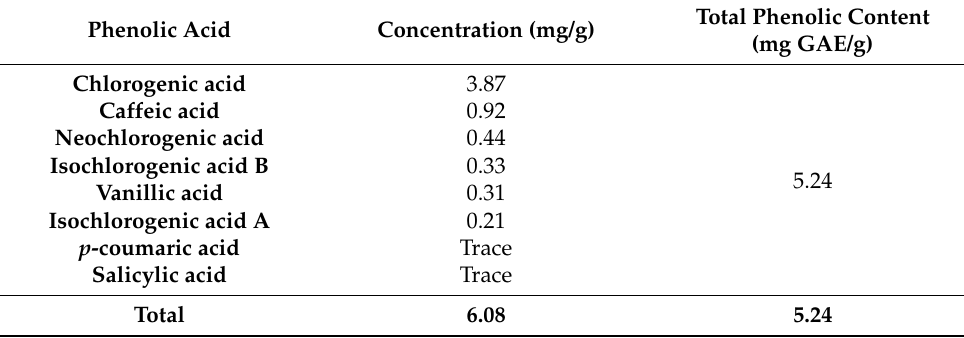
Table 2. Identification and quantification of phenolics in the samples of potato